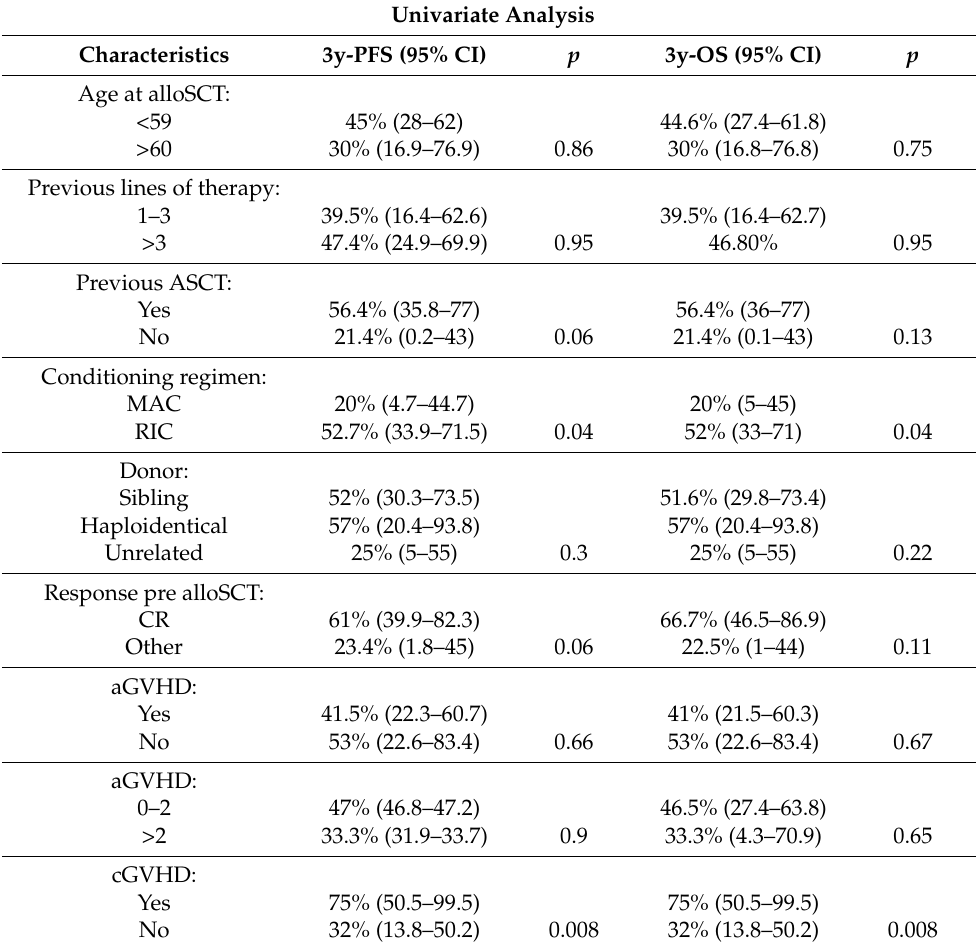
Table 3. Univariate analysis of survival.